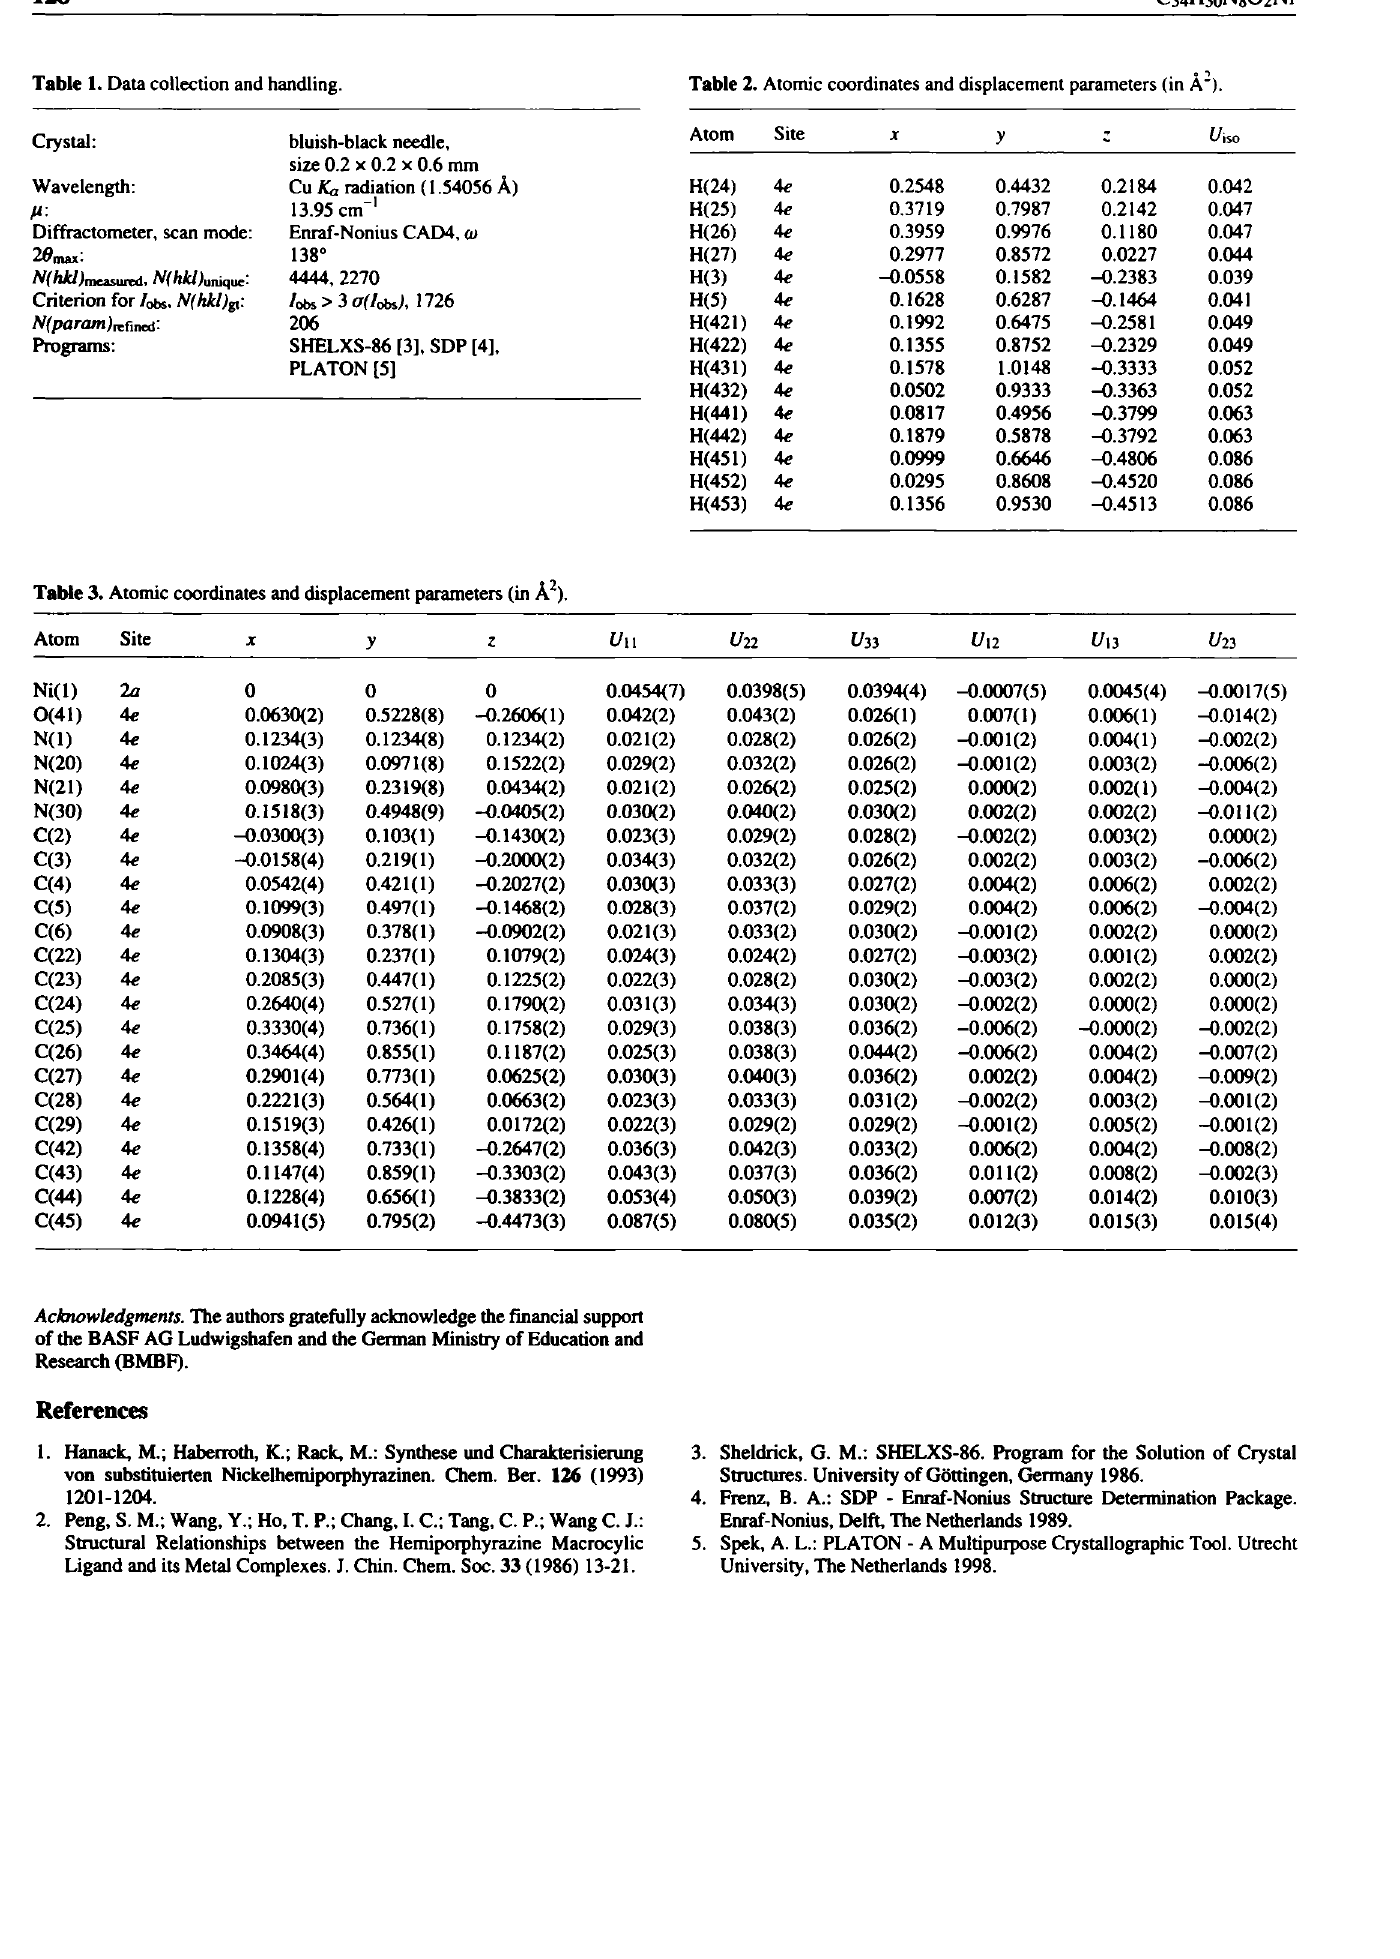
Table 3. Atomic coordinates and displacement parameters (in Â 2